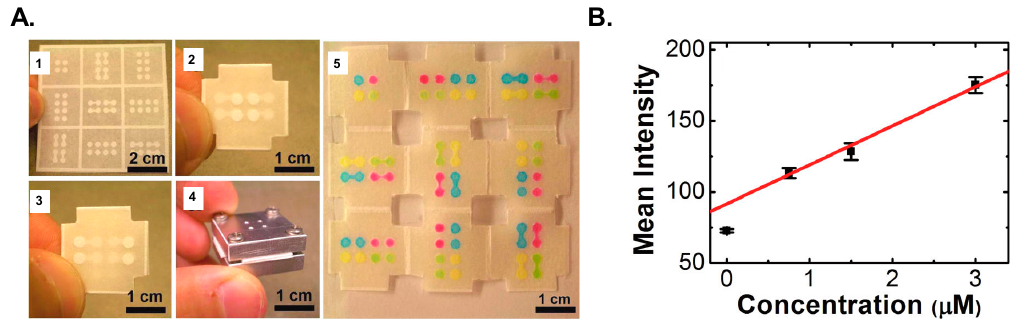
Figure 5. Paper-based microfluidics [94]. ( A ) A 3D paper-based immunosensor using an origami method: 1 . Photolithographically patterned channels on chromatography paper; 2 . Top layer of